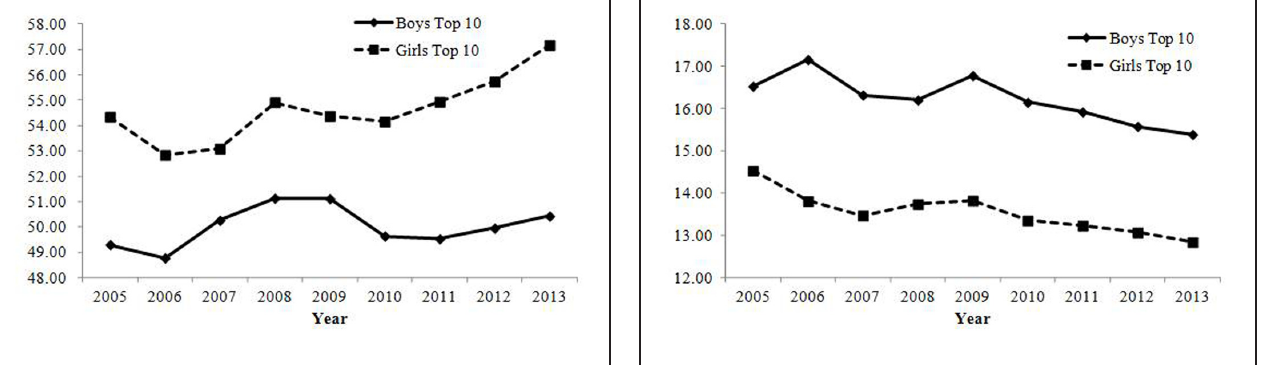
results revealed that the rate of parents who chose common combinations of Chinese characters did not change over time.